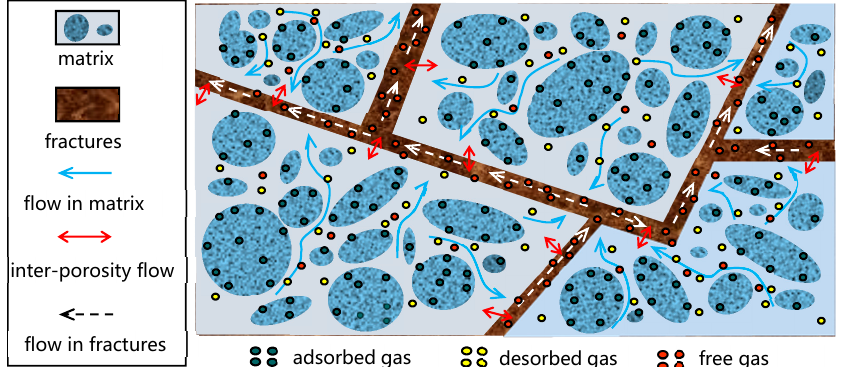
Figure 3. Gas storage and flow mechanisms in shale gas reservoirs.